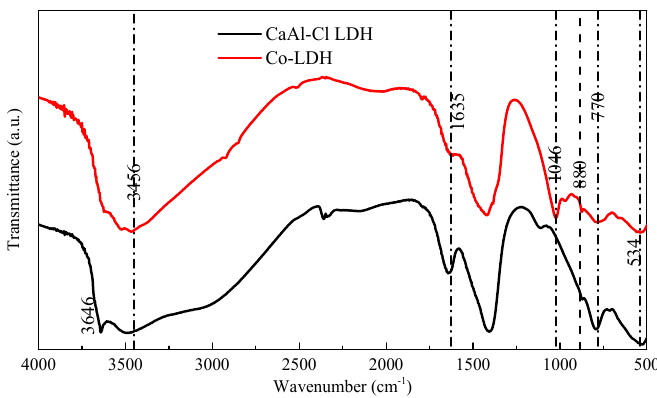
Figure 2. FT-IR spectra of CaAl-Cl-LDH and Co-adsorbed LDH at the concentration of 8 Figure 2. FT‐IR spectra of CaAl‐Cl‐LDH and Co‐adsorbed LDH at the concentration of 8 mM.